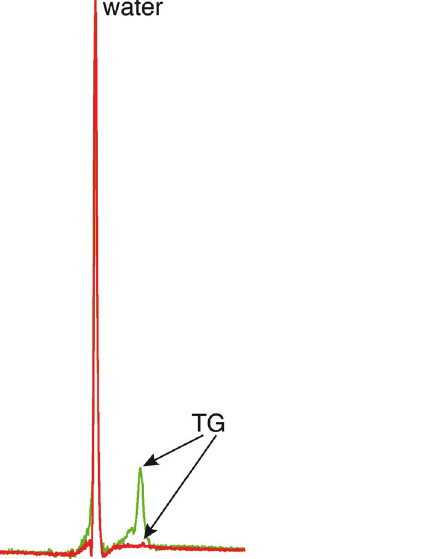
Figure 3. Examples of spectra including the renal parenchyma and sinus, and including only the renal parenchyma. Unsup- pressed localized renal proton spectra of triglyceride (TG) content with deliberate planning of the voxel including the renal sinus (in green) and including only the renal parenchyma (in red). Percentages TG content in this particular volunteer were 18% (renal sinus) and 0.64% (parenchyma).